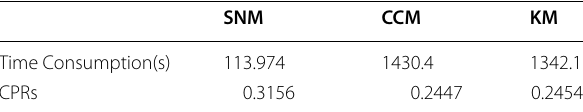
Table 7 The time consumption and CPRs of different